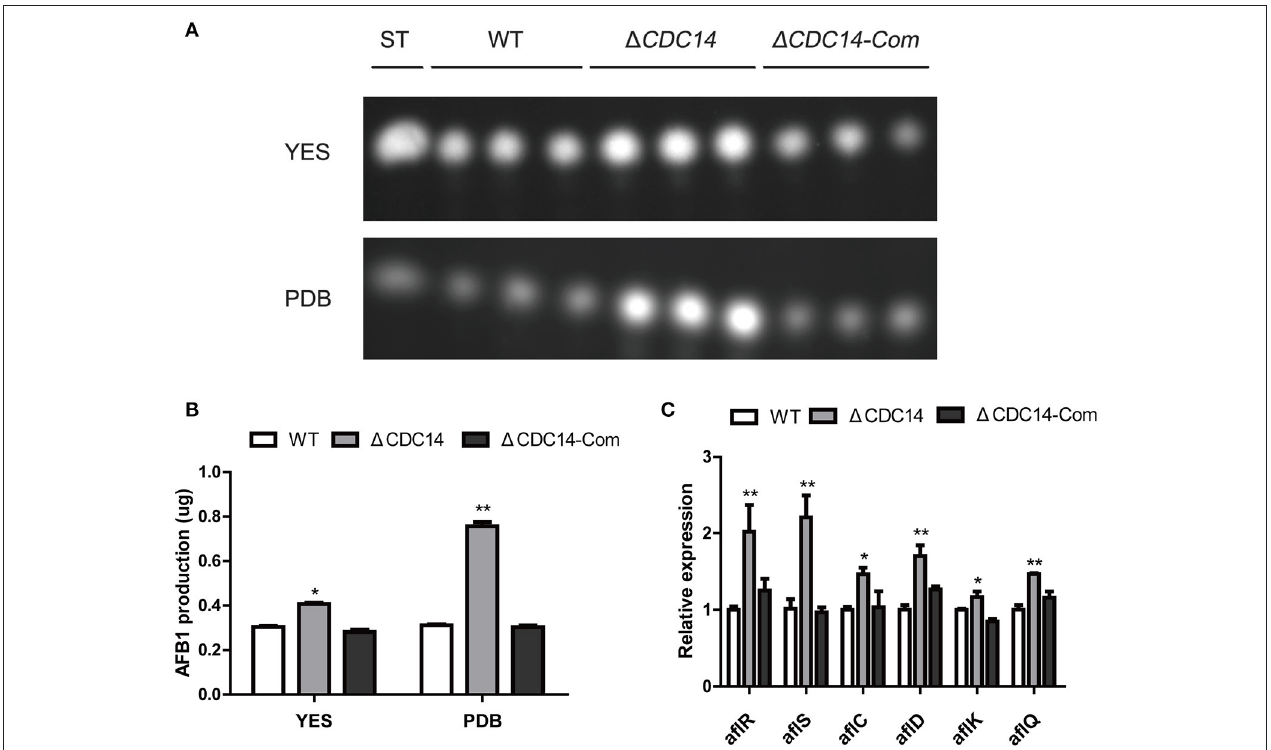
FIGURE 6 | Aflatoxin production of the WT, 1 CDC14 and 1 CDC14- Com strains. (A) TLC assay of AFB1 production by the WT, 1 CDC14 and 1 CDC14- Com strains in YES and PDB liquid media cultured at 29 ◦ C for 6 days. ST indicates AFB1 standard. (B) Quantification analysis of AFB1 as in (A) . (C) Relative transcript levels of six aflatoxin biosynthesis-related genes in different strains for 48h. Actin was used as the endogenous gene, and calculated by 2 − 11 Ct method (* p ≤ 0.05, ** p ≤